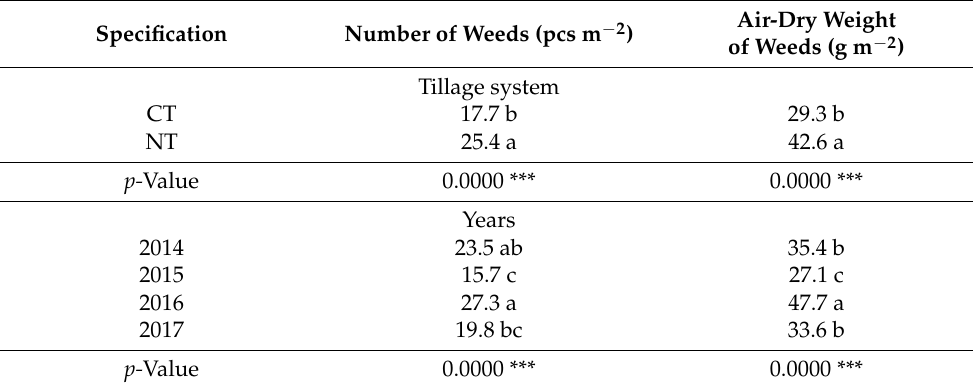
Table 6. Number and air-dry weight of weeds in winter oilseed rape crop depending on tillage system (mean for 2014–2017) and years of